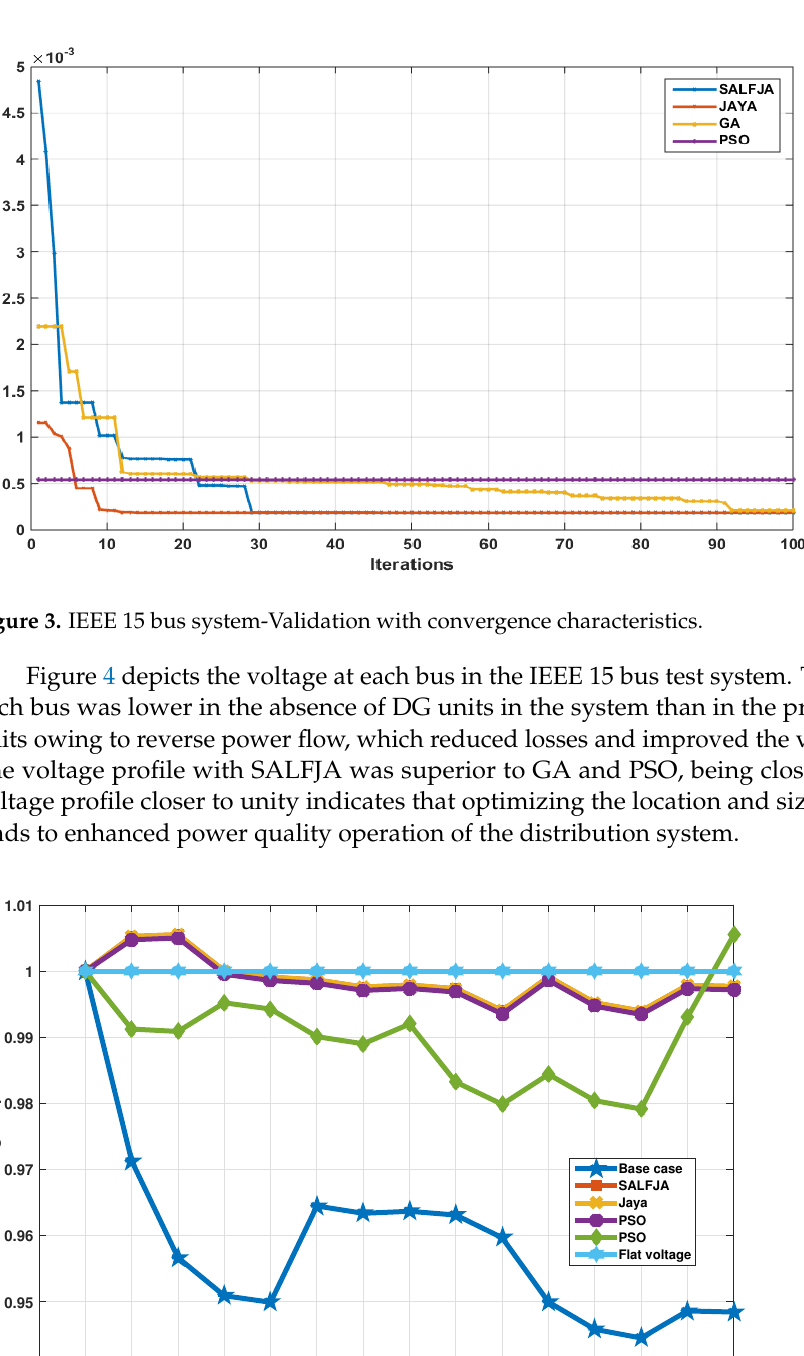
Figure 4. IEEE 15 bus system: Voltage